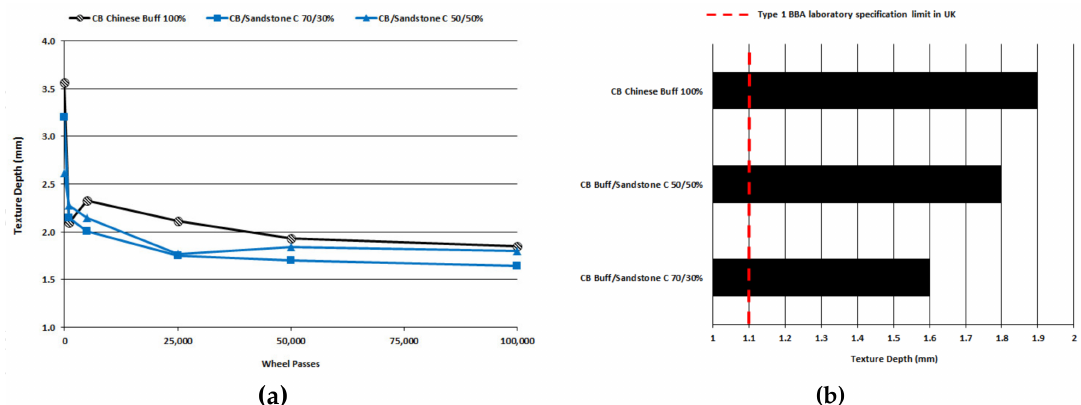
Figure 9. ( a ) Texture depth development up to 100,000 wheel-passes; ( b ) texture depth ranking after 100,000 wheel-passes (Ulster University